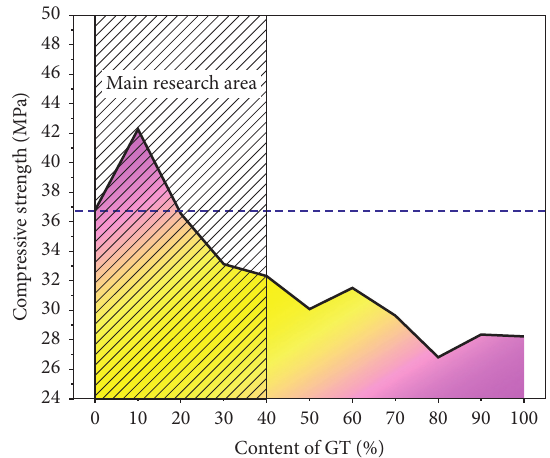
Figure 3: Compressive strength of GTC (0% to